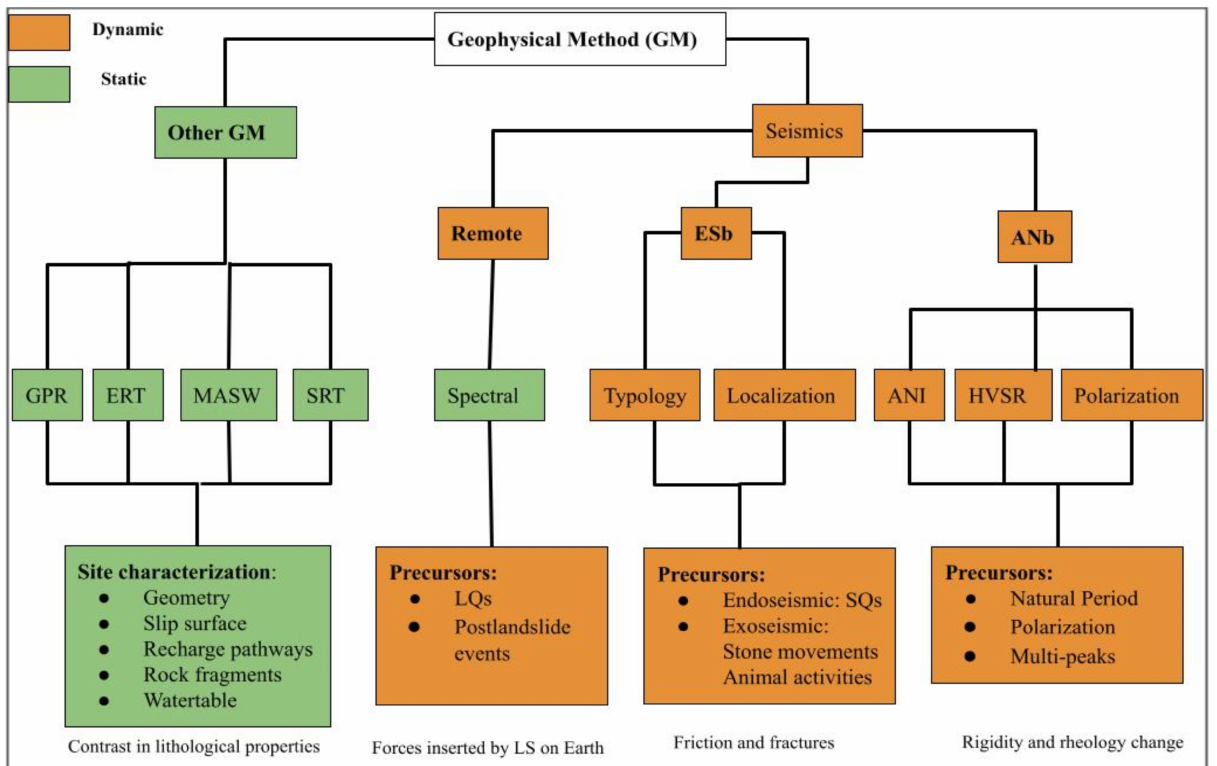
Figure 2. Classification of geophysical methods applied for landslide displacement monitoring, structural characterization and